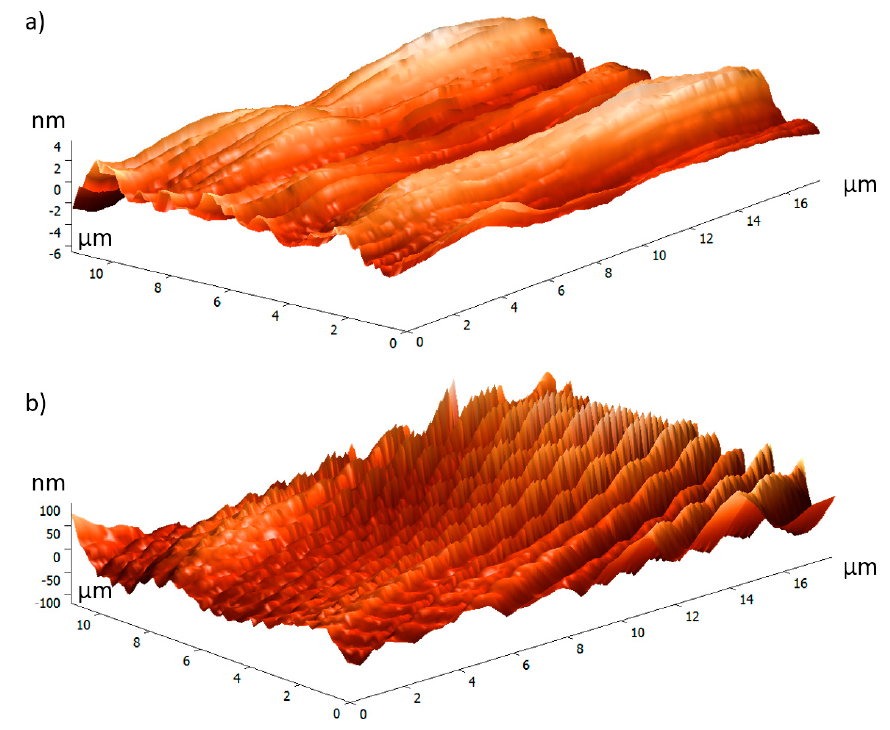
Figure 5. AFM-3D images of pure Cu ( a ) and Cu structured with the CNTs ( b ).